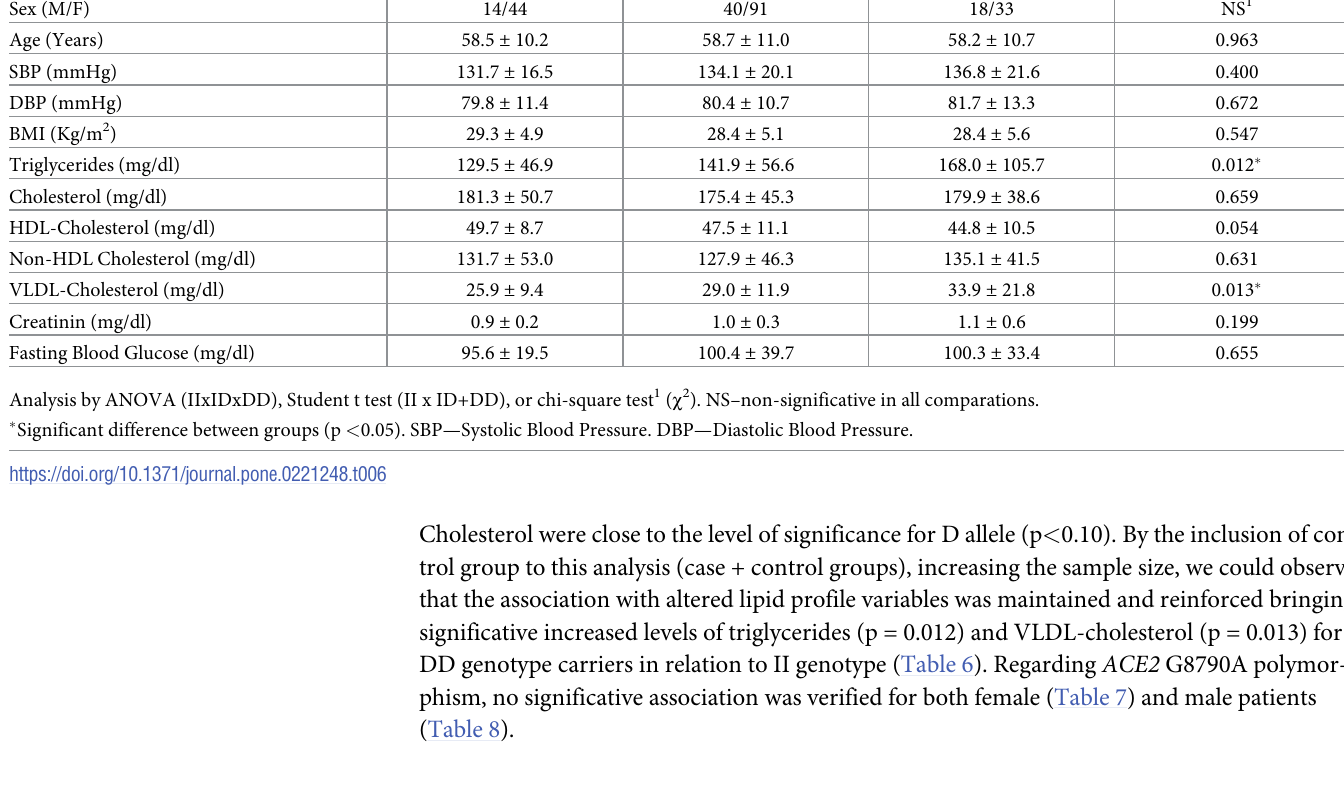
Table 7. Analysis of the influence of ACE2 G8790A polymorphism on clinical-laboratory variables among HAS female patients. Variables